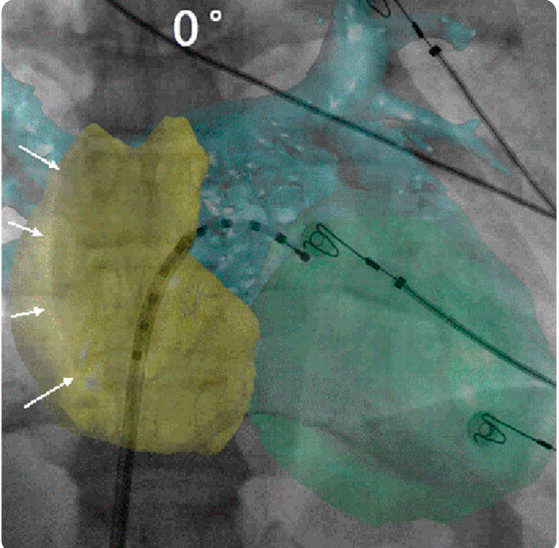
Figure 11. EPNavigator software and its role in intuitive display. CT registration based on heart contours (including reconstruction of both the atria and left ventricle). Antero-posterior fluoroscopic view with CT overlay. A decapolar catheter is inserted into the left atrium through a trans-septal sheath. The CT volume overlay is first aligned using the right lateral atrial contour (white arrows). Abbreviations: CT, computed tomography. Reprinted from “Computed tomography–fluoroscopy overlay evaluation during catheter ablation of left atrial arrhythmia” by Knecht et al. [66] with written approval from the corresponding author and publisher (EP Europace; Copyright 2008).